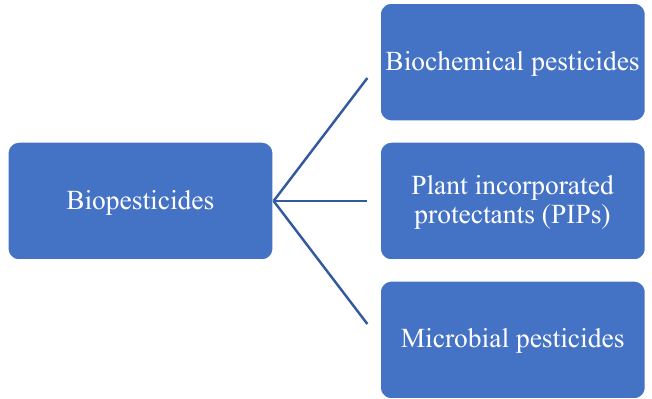
Figure 4. Classification of biopesticides.